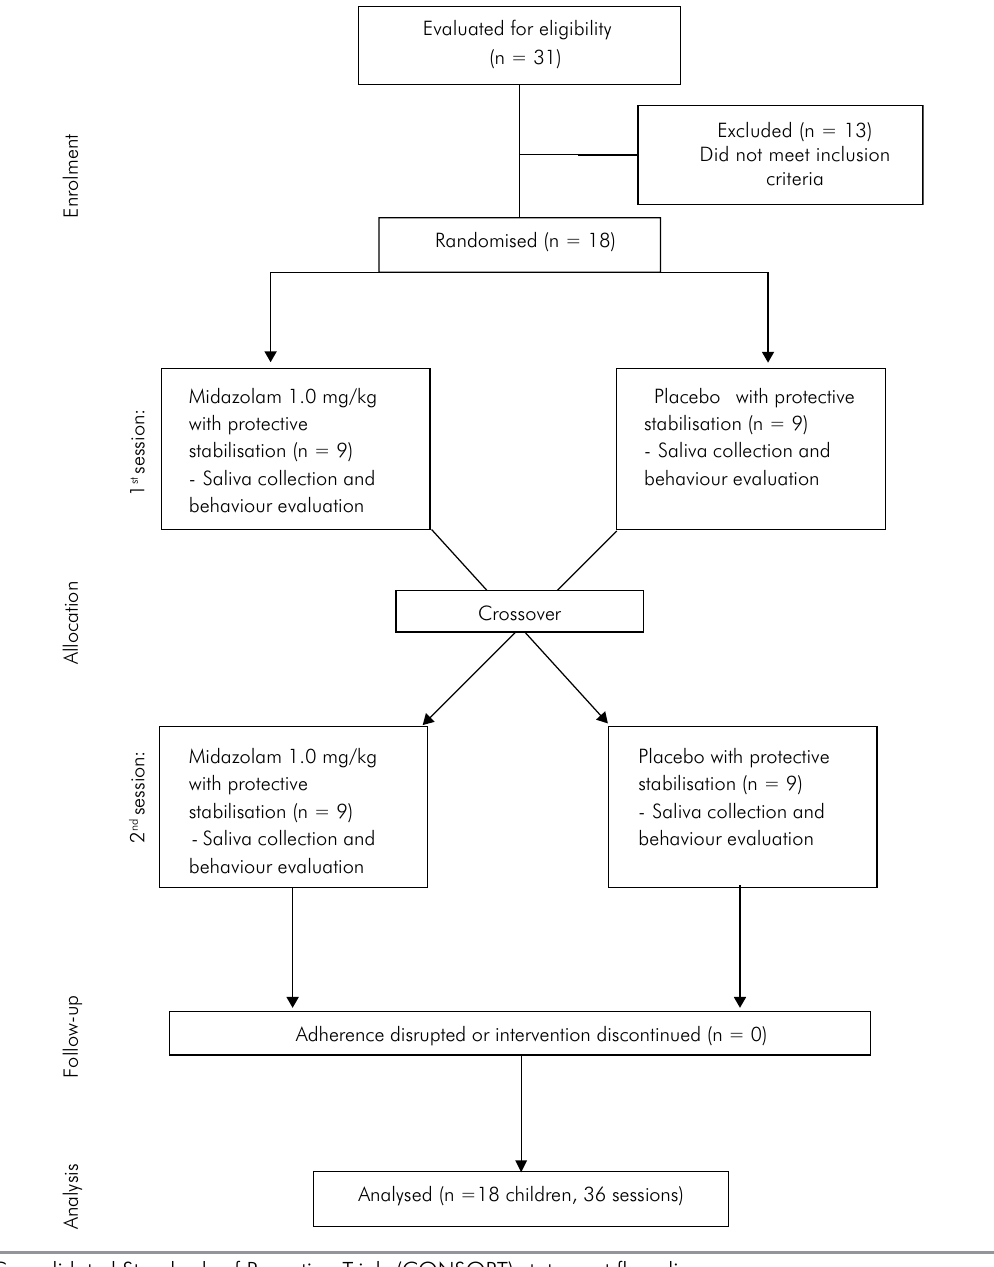
Figure 1. Consolidated Standards of Reporting Trials (CONSORT) statement flow